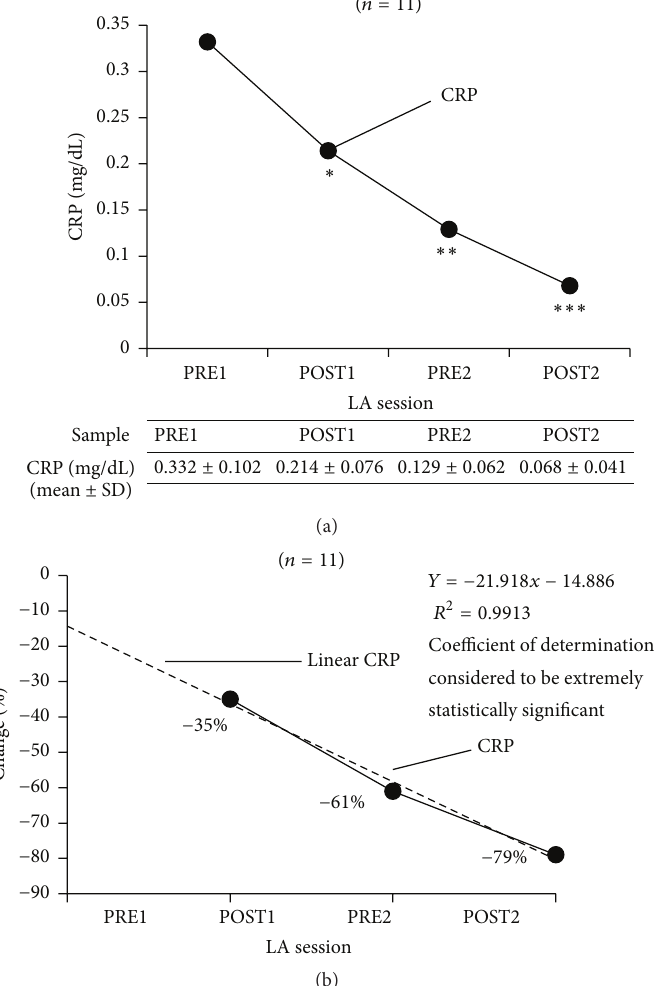
Figure 3: Effect of LA treatment on CRP expression (a), change in expression (b). ∗ PRE1 versus POST1 two-tailed 𝑝 value of 0.0039 (considered to be very statistically significant). ∗∗ PRE1 versus PRE2 two-tailed 𝑝 value < 0.0001 (considered to be extremely statistically significant). ∗∗∗ PRE2 versus POST2 two-tailed 𝑝 value < 0.0001 (considered to be extremely statistically significant). LA, lipoprotein